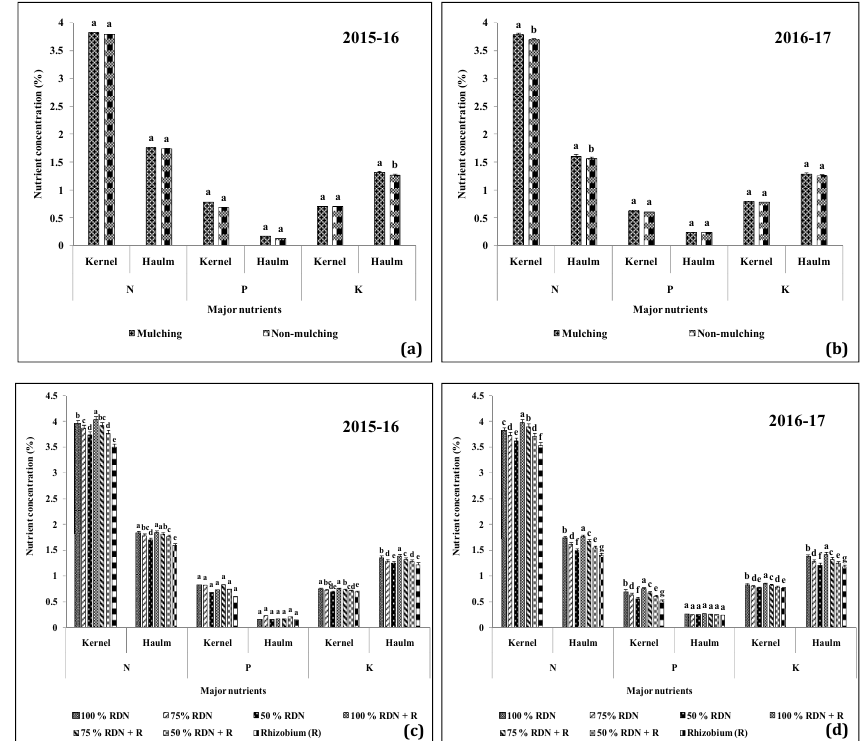
Figure 8. Effect of mulch ( a , b )and nutrient dose ( c , d ) on nutrient concentration (%) in different plant parts at harvest of peanut (data from 2015–2016 and 2016–2017 crop seasons, respectively); within treatments, different letters indicate significant differences at p ≤ 0.05 (otherwise statistically at par); error bars represent the least significant difference value.